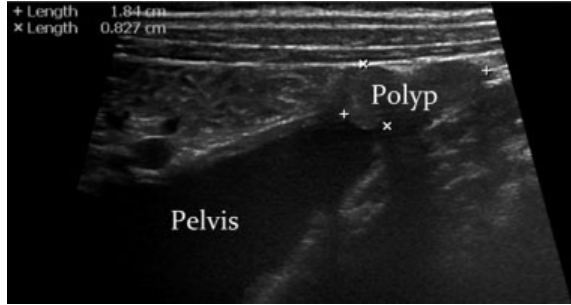
Fig. 3 Transmesocolic view of ureteral polyp after dissecting the